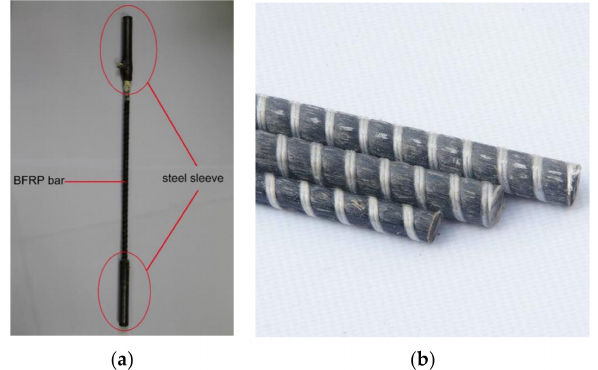
Figure 3. Basalt fiber–reinforced polymer (BFRP) bars: ( a ) BFRP specimen in tensile test; and ( b ) BFRP bars with different diameters.